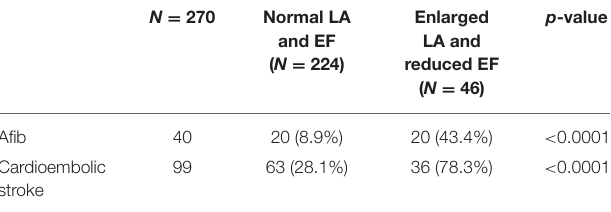
TABLE 4 | LA enlargement and reduced EF in patients with Afib and cardioembolic